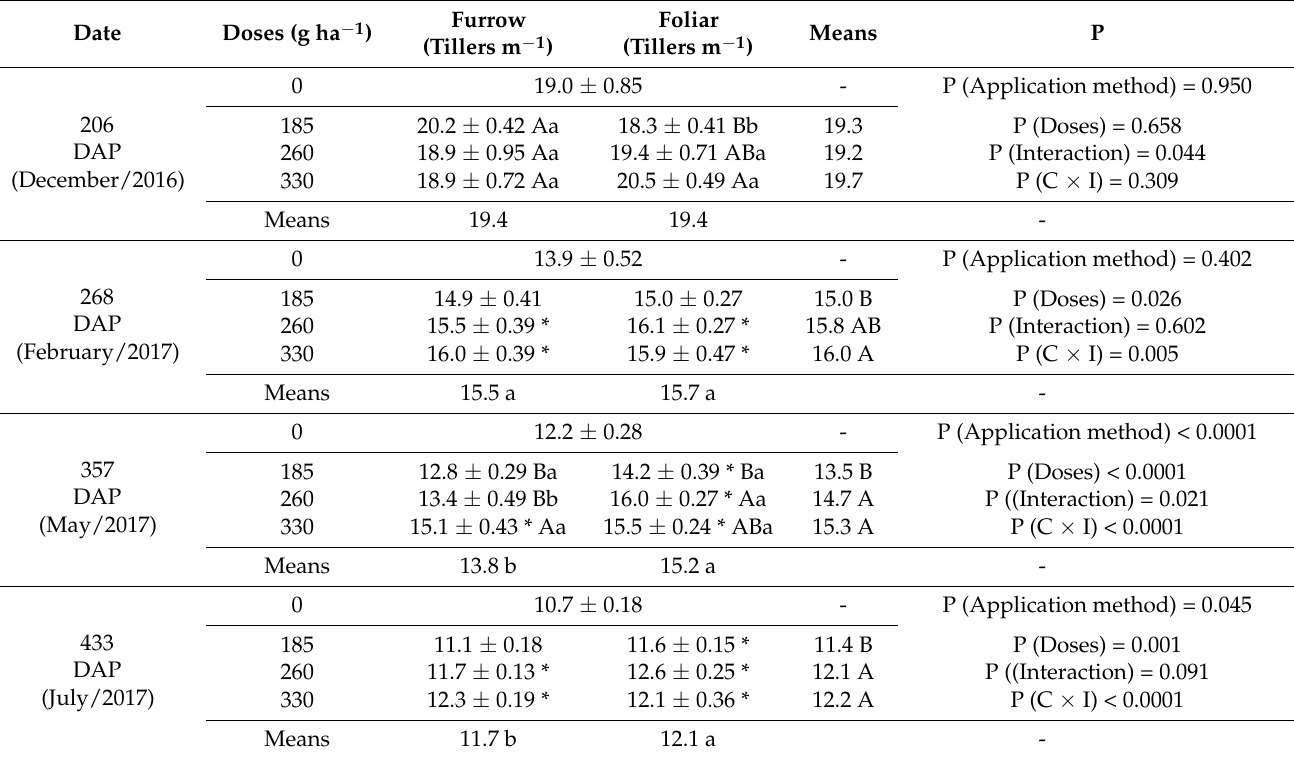
Df, degrees of freedom; average ± standard error; averages followed by different capital letters indicate significant differences between the application methods and averages followed by different lowercase letters indicate significant differences between the doses by Tukey’s test ( p ≤ 0.05). * Averages followed with an asterisk differ from the control ( p ≤ 0.05); (C × I): Control ×